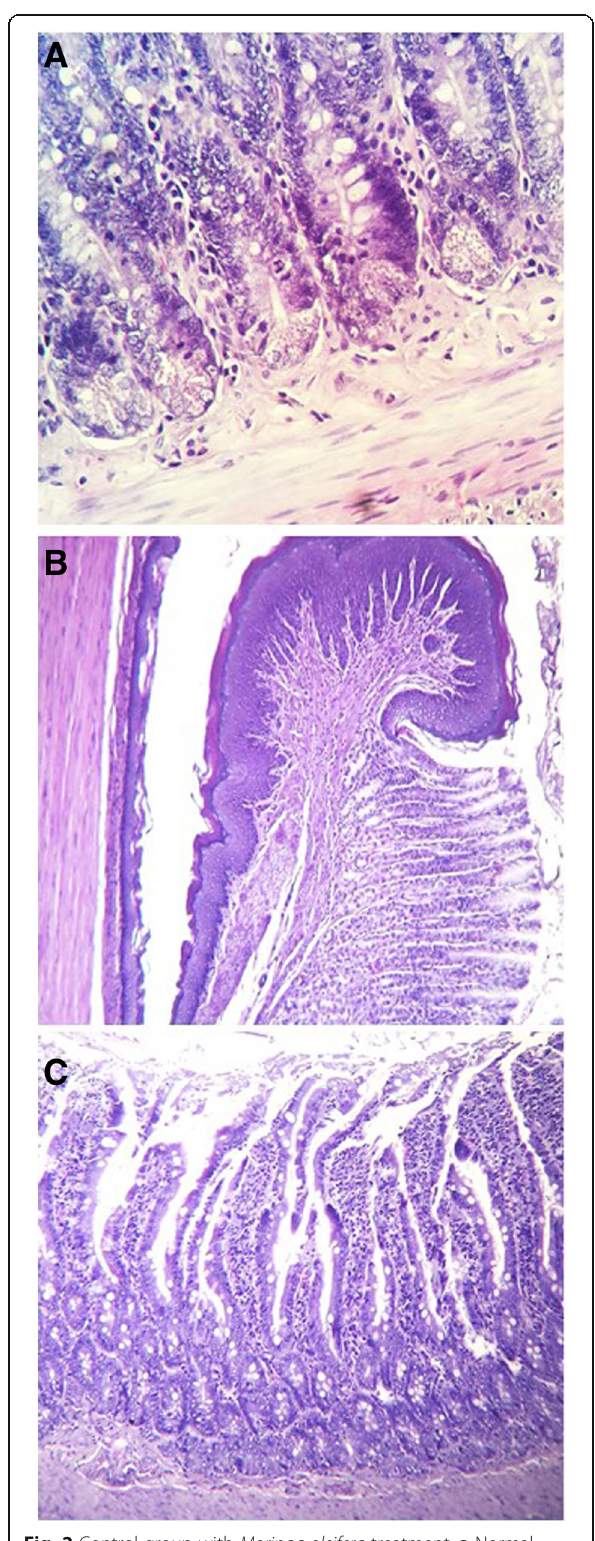
Fig. 2 Control group with Moringa oleifera treatment. a Normal architecture of the large intestine. b Normal gastroesophageal union was observed. c No changes in small